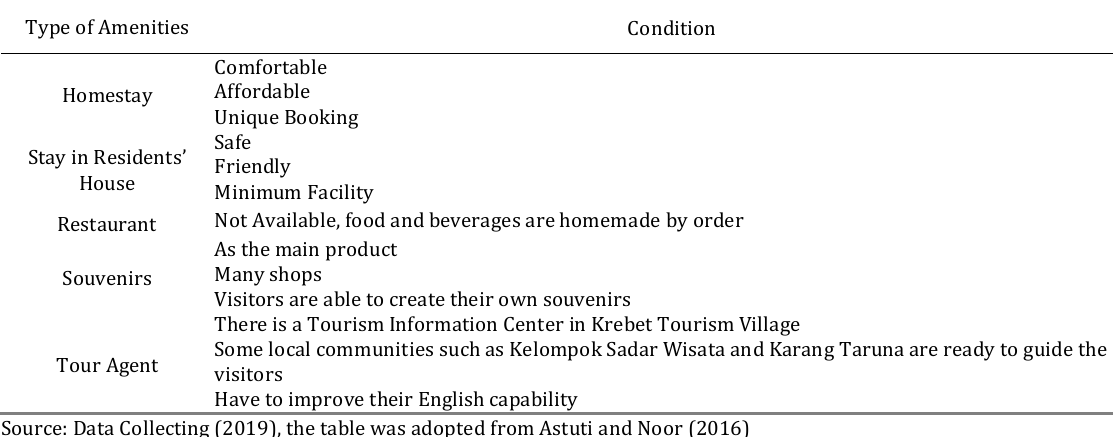
Table 3 Amenities in Krebet Tourism